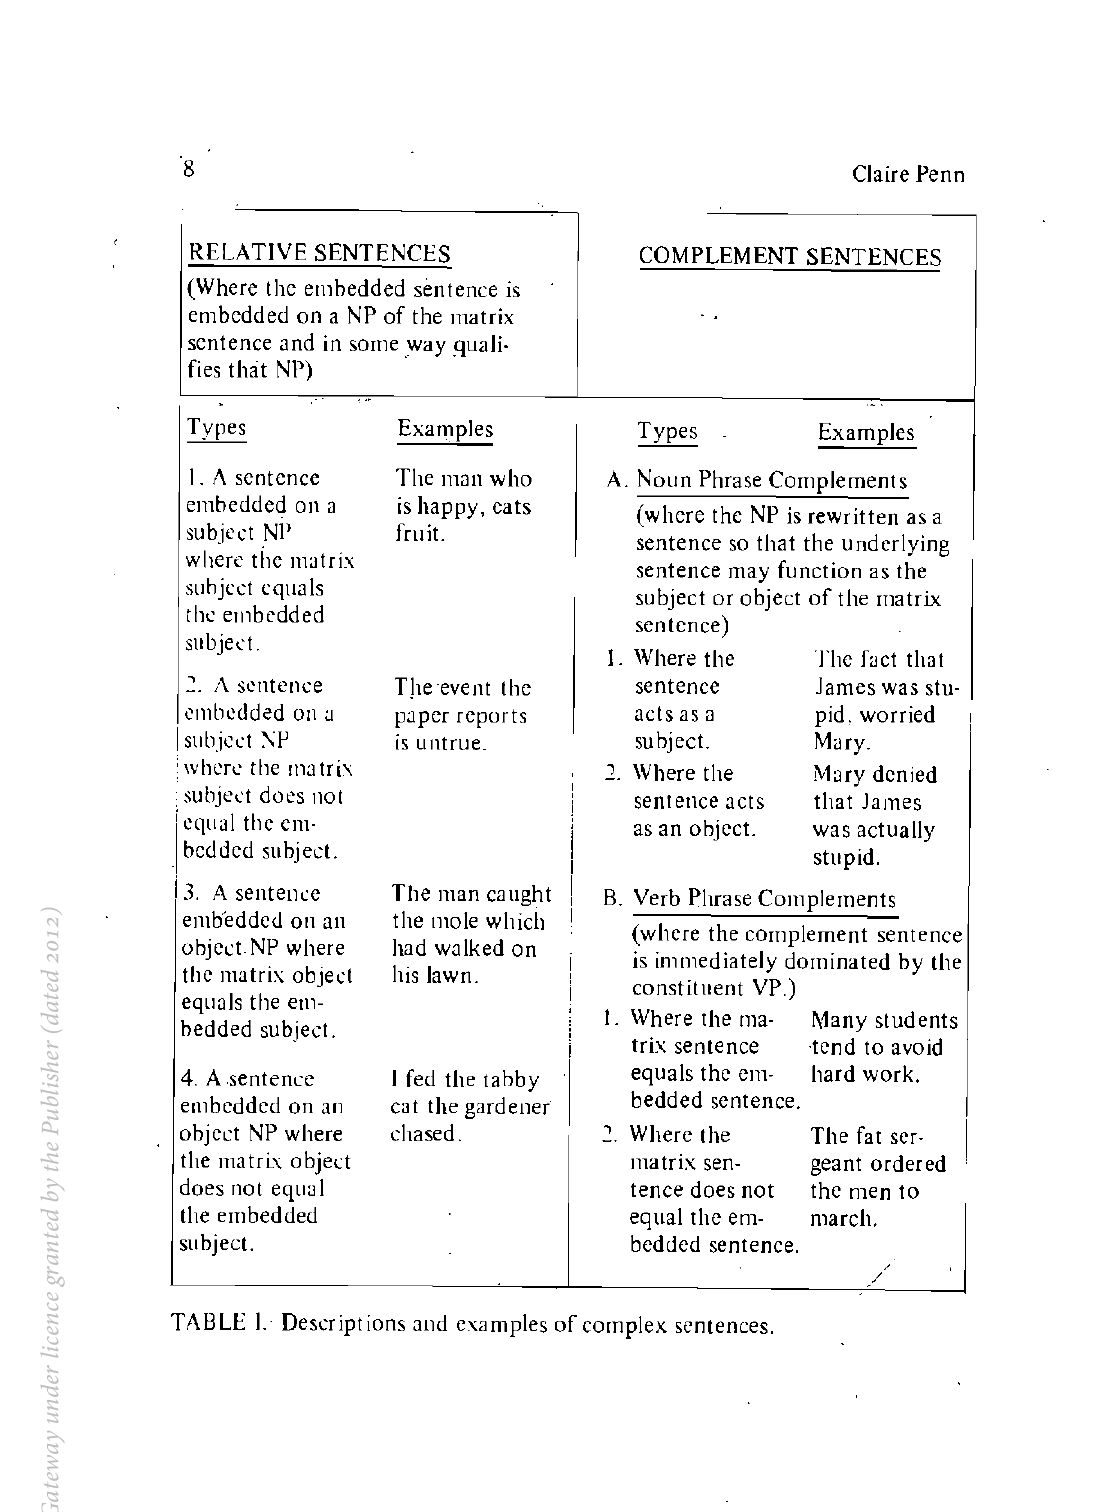
TABLE 1. Descriptions and examples of complex